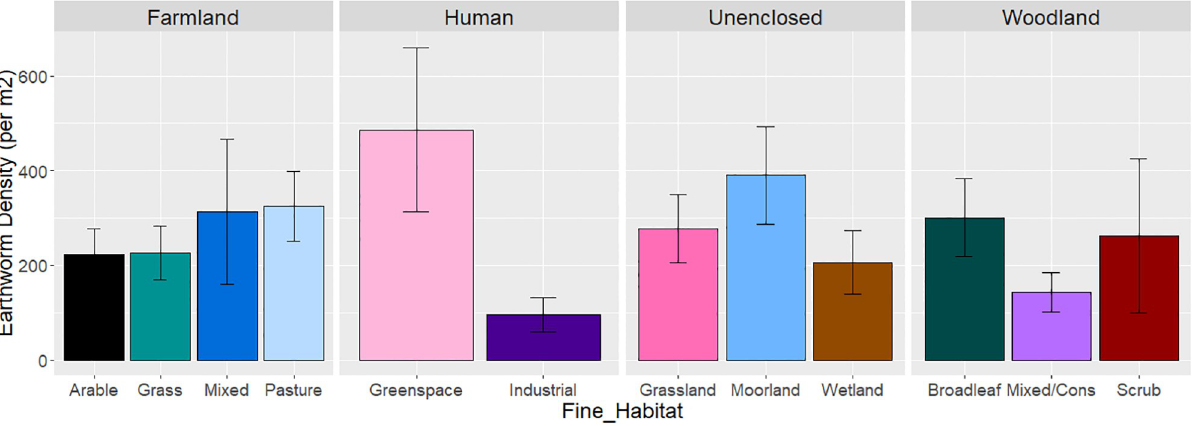
Fig 5. Fine_Habitat specific earthworm density. Average earthworm density per m 2 for each Fine_Habitat category from Model 2 (unweighted). See Table 4 for estimates.